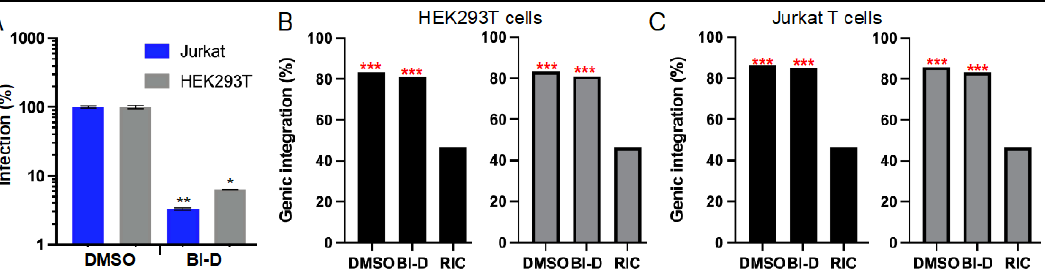
Figure 3. Genic integration profiles of HIV-Luc produced in the presence of BI-D. ( A ) HIV-Luc infectivities in HEK293T cells and Jurkat T cells following exposure to 600 nM BI-D or DMSO during virus production. Results (average ± standard deviation from two independent experiments; within each experiment, luciferase values were determined for technical triplicate samples) are percent normalized to the indicated DMSO-treated cell type. *, p < 0.01; **, p < 0.001 (Table S1). ( B ) Percent integration in RefSeq genes in HEK293T cells for the infections shown in panel ( A ). The left graph shows results for replicate 1. ( C ) Same as in panel ( B ), except for Jurkat T cells—see Table 2 for plotted values and Table S3 for pairwise statistical comparisons. ***, p < 0.0001 versus random integration control (RIC). Table 2. Integration sites derived from BI-D-treated virions 1 .